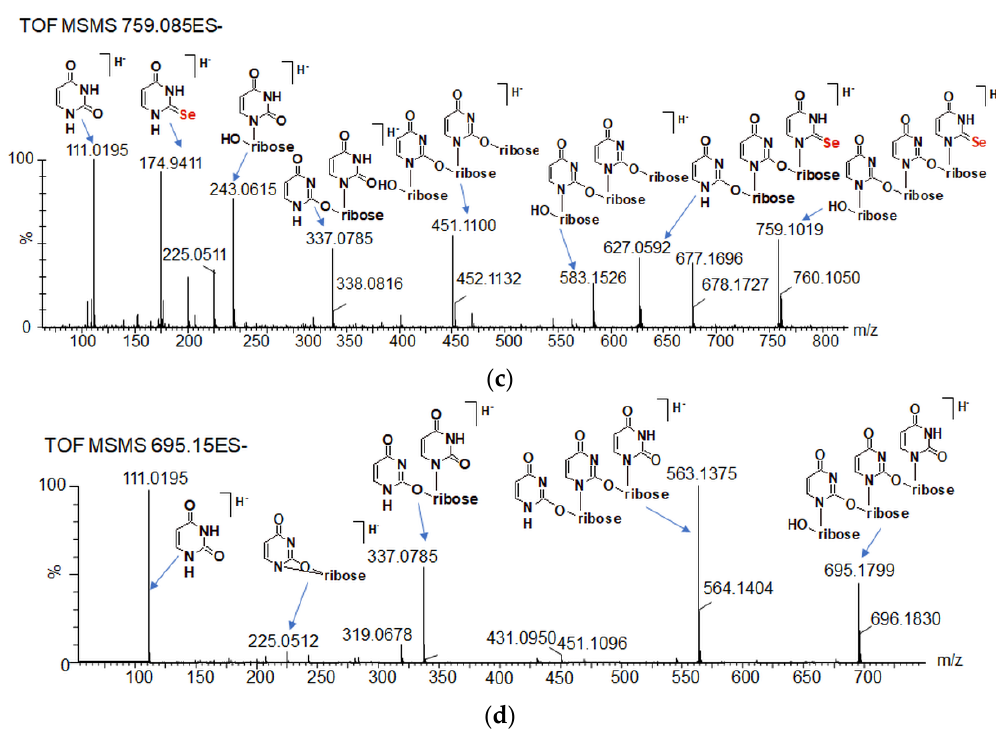
Figure 9. UPLC/ESI(-)-MS/MS spectra of the [M-H] − of 5 ( a ), 6 ( b ), 7 ( c ), and 8 ( d ) recorded with collision energy ramping from 15 to 35 eV.